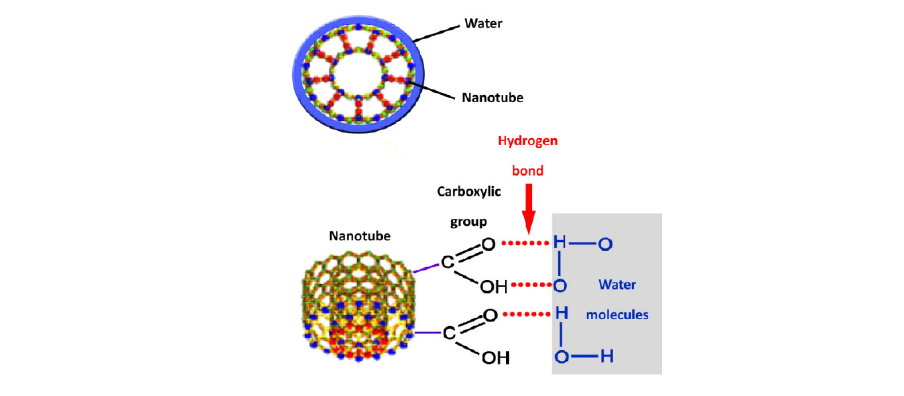
Figure 13: Possible interaction between COOH-MWCNTs and water molecules during cement hydration process [17]. CNT S IDEAL CONTENT